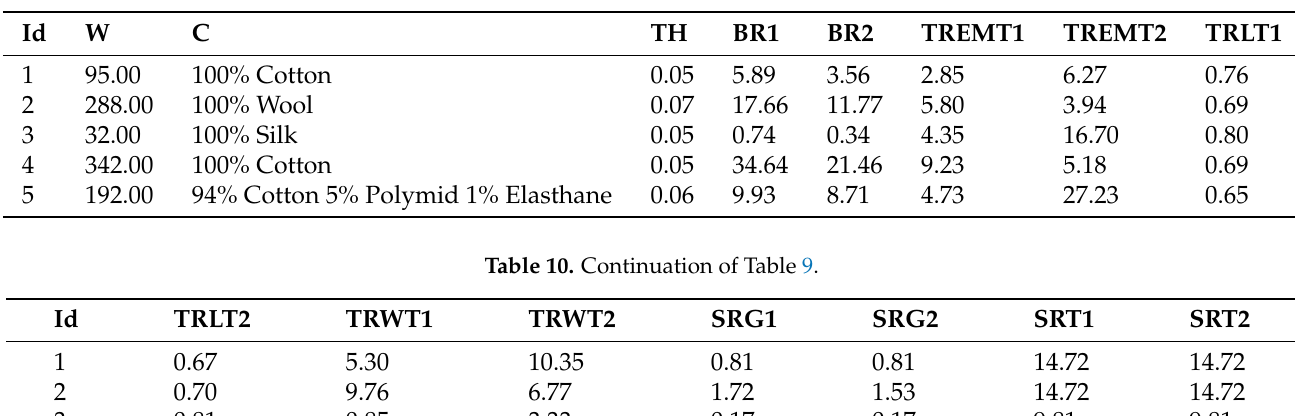
Table 9. Fabric data with mechanical properties.